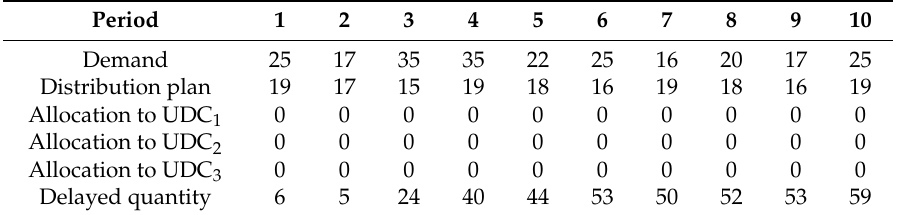
Table 9. Final distribution plan without the subcontracting strategy with available